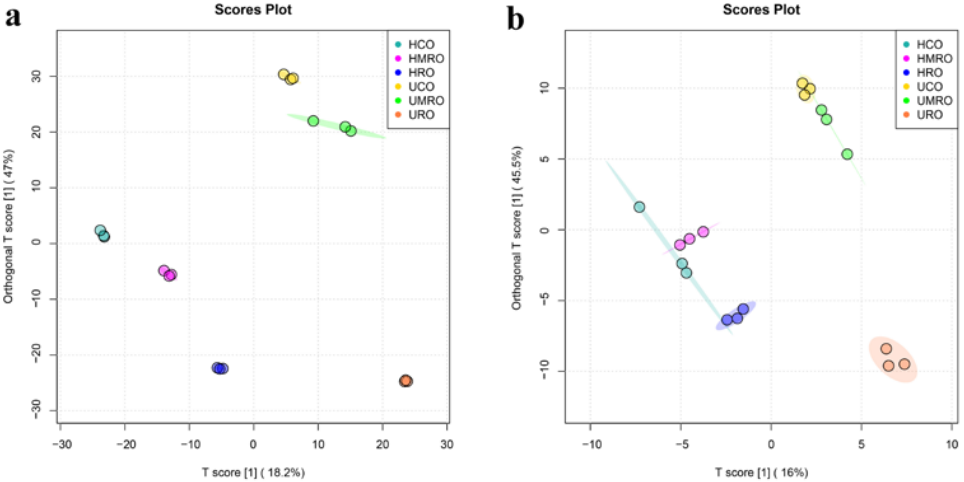
Figure 10. PCA scores plots of camellia oil before and after heating based on non-targeted lipidomics: ( a ) positive ion mode; ( b ) negative ion mode.